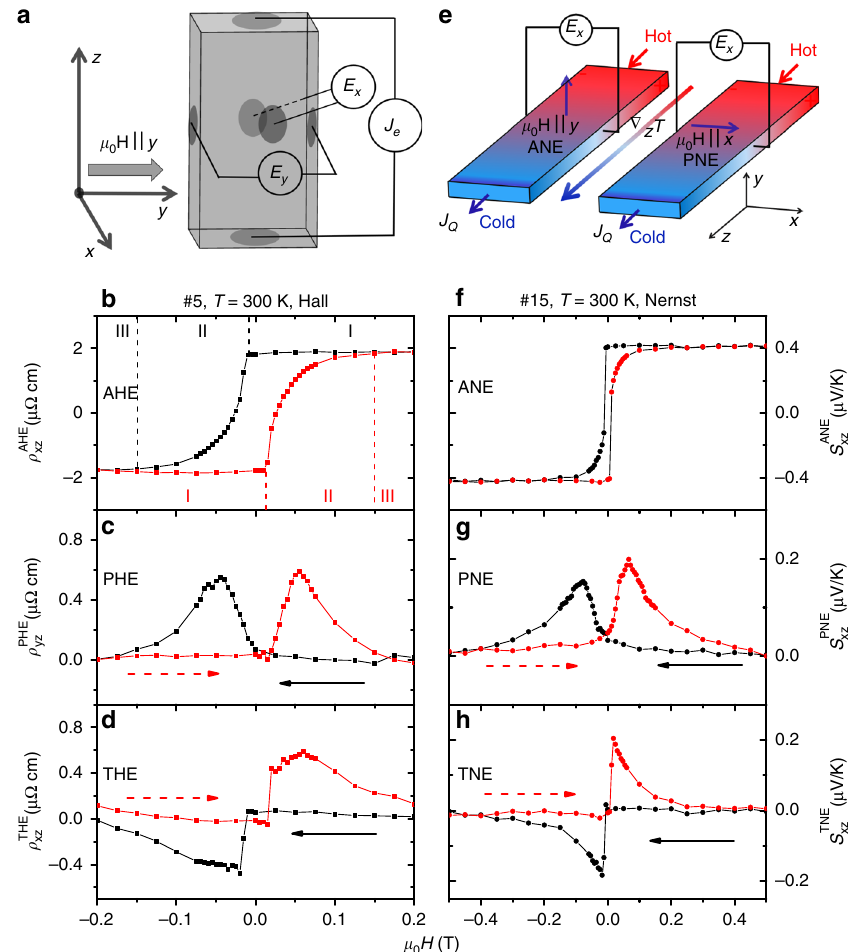
Fig. 1 Room-temperature anomalous transverse response. a Experimental con fi guration for measuring Hall effect in sample #5 with square cross-section. Charge current is applied along the z -axis and the magnetic fi eld along the y -axis. Two pairs of electrodes measure E x and E y . b Anomalous Hall resistivity ( ρ AHE xz ), extracted from E x . c Planar Hall resistivity ( ρ PHE yz ), extracted from E y . d Topological Hall resistivity ( ρ THE xz ), extracted by subtracting magnetization and Hall hysteresis loops, see Supplementary Note 4. e Experimental con fi guration for measuring Nernst effect in sample #15 with rectangular cross- section. The temperature gradient is applied along the z -axis, the magnetic fi eld is applied either along x -axis or y -axis. The electric fi eld is always measured along the x -axis. f Anomalous Nernst effect ( S ANE xz ) with the magnetic fi eld along the y -axis, extracted from E x . g Planar Nernst effect ( S PNE xz ) measured with the magnetic fi eld along x -axis, extracted from E x . h Topological Nernst effect ( S TNE xz ) extracted by subtracting magnetization and Nernst hysteresis loops, see Supplementary Note 4. The larger width of the hysteresis loop in the Nernst measurements is due to the larger aspect ratio of the sample (See Fig.